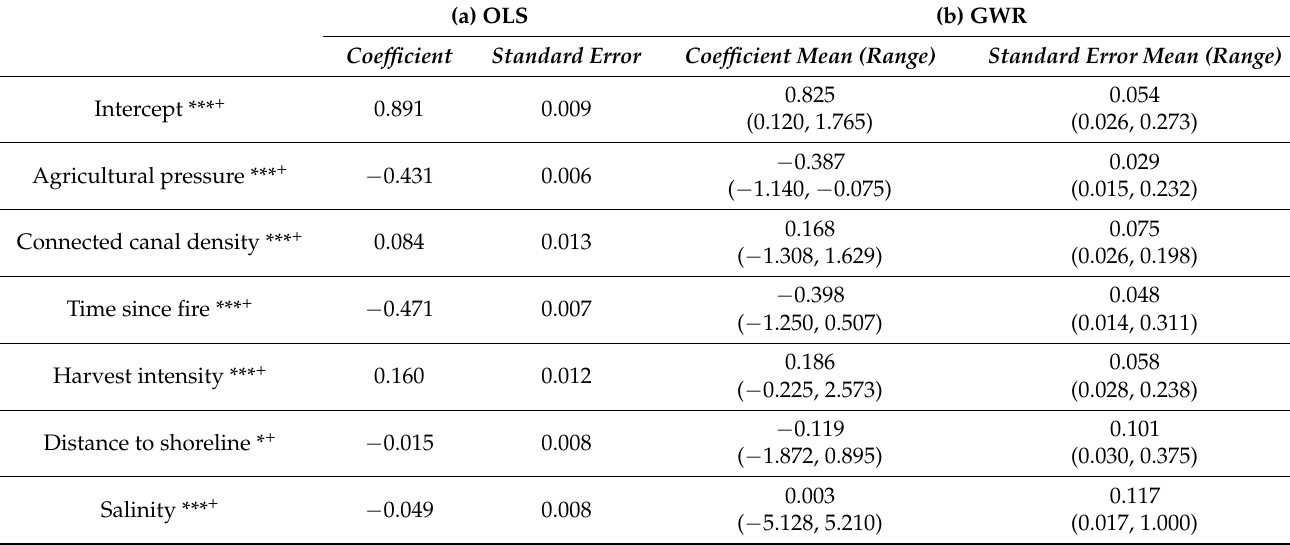
Table 2. ( a ) Coefficient and standard errors for predictor variables used in the global ordinary least squares (OLS) regression model. ( b ) Coefficient mean (and range) and standard error mean (and range) for the local geographically weighted regression (GWR) model. + denotes nonstationarity in the relationship between predictor variable and response in the GWR model as calculated by the Breusch–Pagan